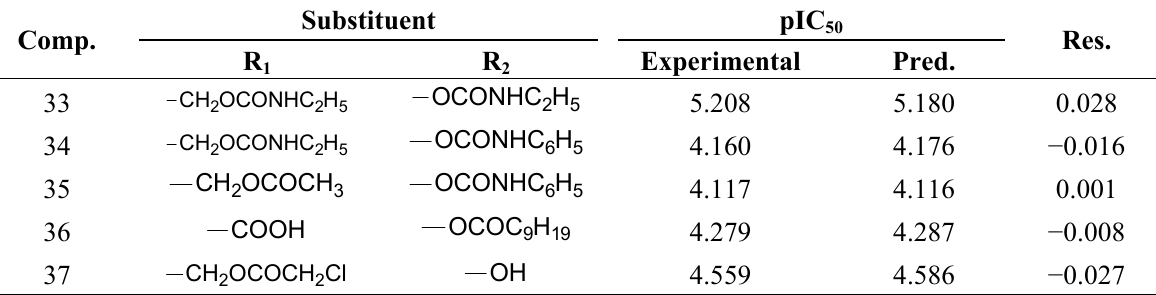
values of the training and test 50